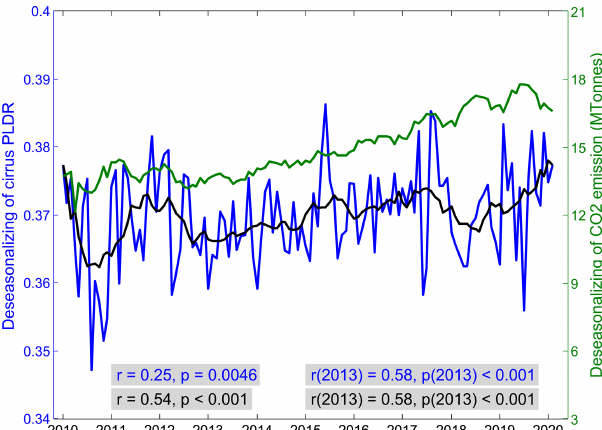
Figure 9. Comparison between the deseasonalized time series of cirrus PLDR (in blue) and the corresponding deseasonalized CO 2 emissions from aviation in Europe (in green). The annual mean vari- ations of the deseasonalized PLDR are overplotted with a 12-point moving average smooth (in black). The correlation coefficients be- tween both parameters for a full period as well as for a shorter pe- riod from January 2013 are calculated and indicated on the plot, which are all at the confidence level above